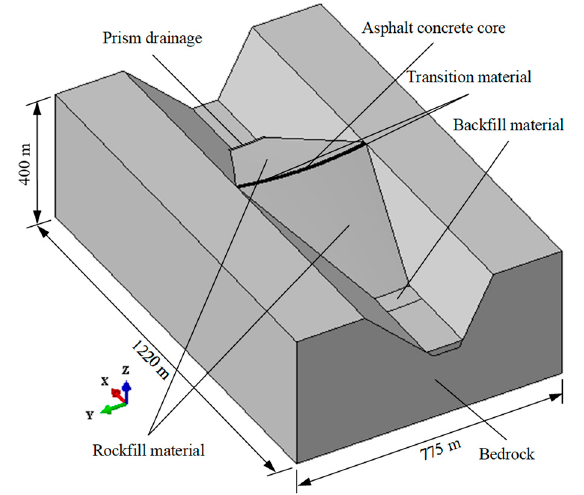
Figure 26. Material regions of FEM standard model for CACCRDs.